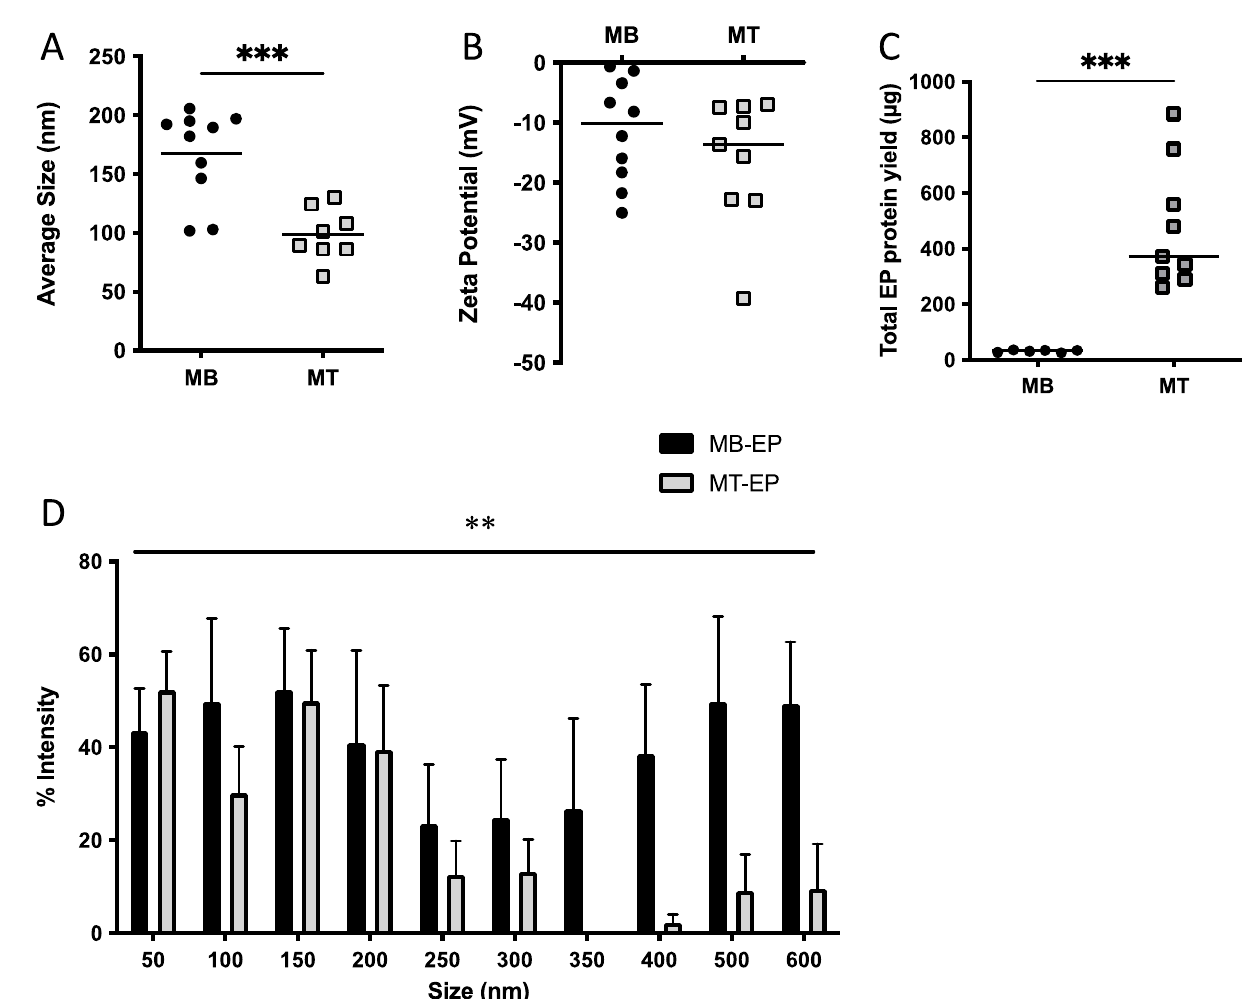
Figure 1. Changes in EP biophysical characteristics with skeletal muscle myoblast differentiation into myotubes. ( A ) C2C12 myotube (MT) EPs were 41% smaller than myoblast (MB) EPs (*** p < 0.001, n = 8–10). ( B ) Zeta potential remained unchanged between EPs from myoblasts vs. myotubes, n = 9–10. ( C ) Total protein yield from myotube-EPs was ~15-fold higher than myoblast-EPs (*** p < 0.001, n = 6–9). ( D ) Two-way ANOVA showed a significant main effect for myotube-EPs vs. myoblast-EPs (** p < 0.01, n = 10–13). Myoblast-EPs display a bimodal size distribution profile with a peak for EPs < 200 nm and again at 400–600 nm, compared to myotube-EPs that were enriched with 50–300 nm sized particles. EPs were isolated using Total Exosome Isolation Reagent (ThermoFisher, Waltham, MA, USA). All data were analyzed using an unpaired Student’s t test, except in Figure 1D where a 2-way ANOVA was used. Data are expressed as scatter plots showing mean, or bars with mean ± standard error.